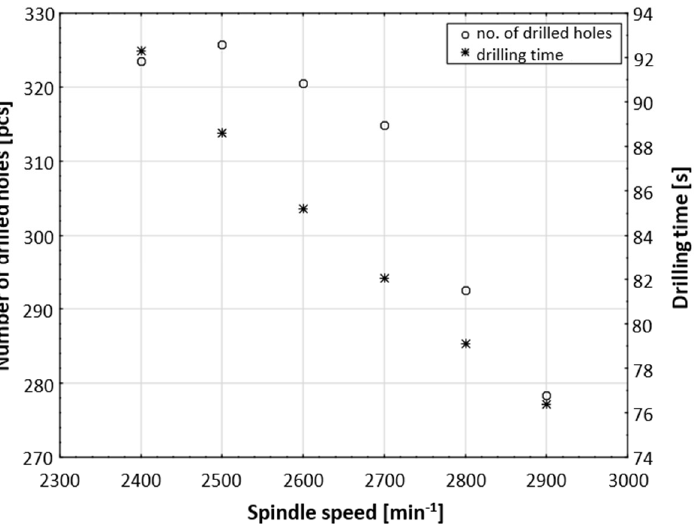
Figure 11. Dependence of the number of holes drilled up to the moment of tool damage and drilling time on speed used in the experiment. Table 2. Results of a comparison of the number of holes drilled up to the moment of tool damage in terms of speed